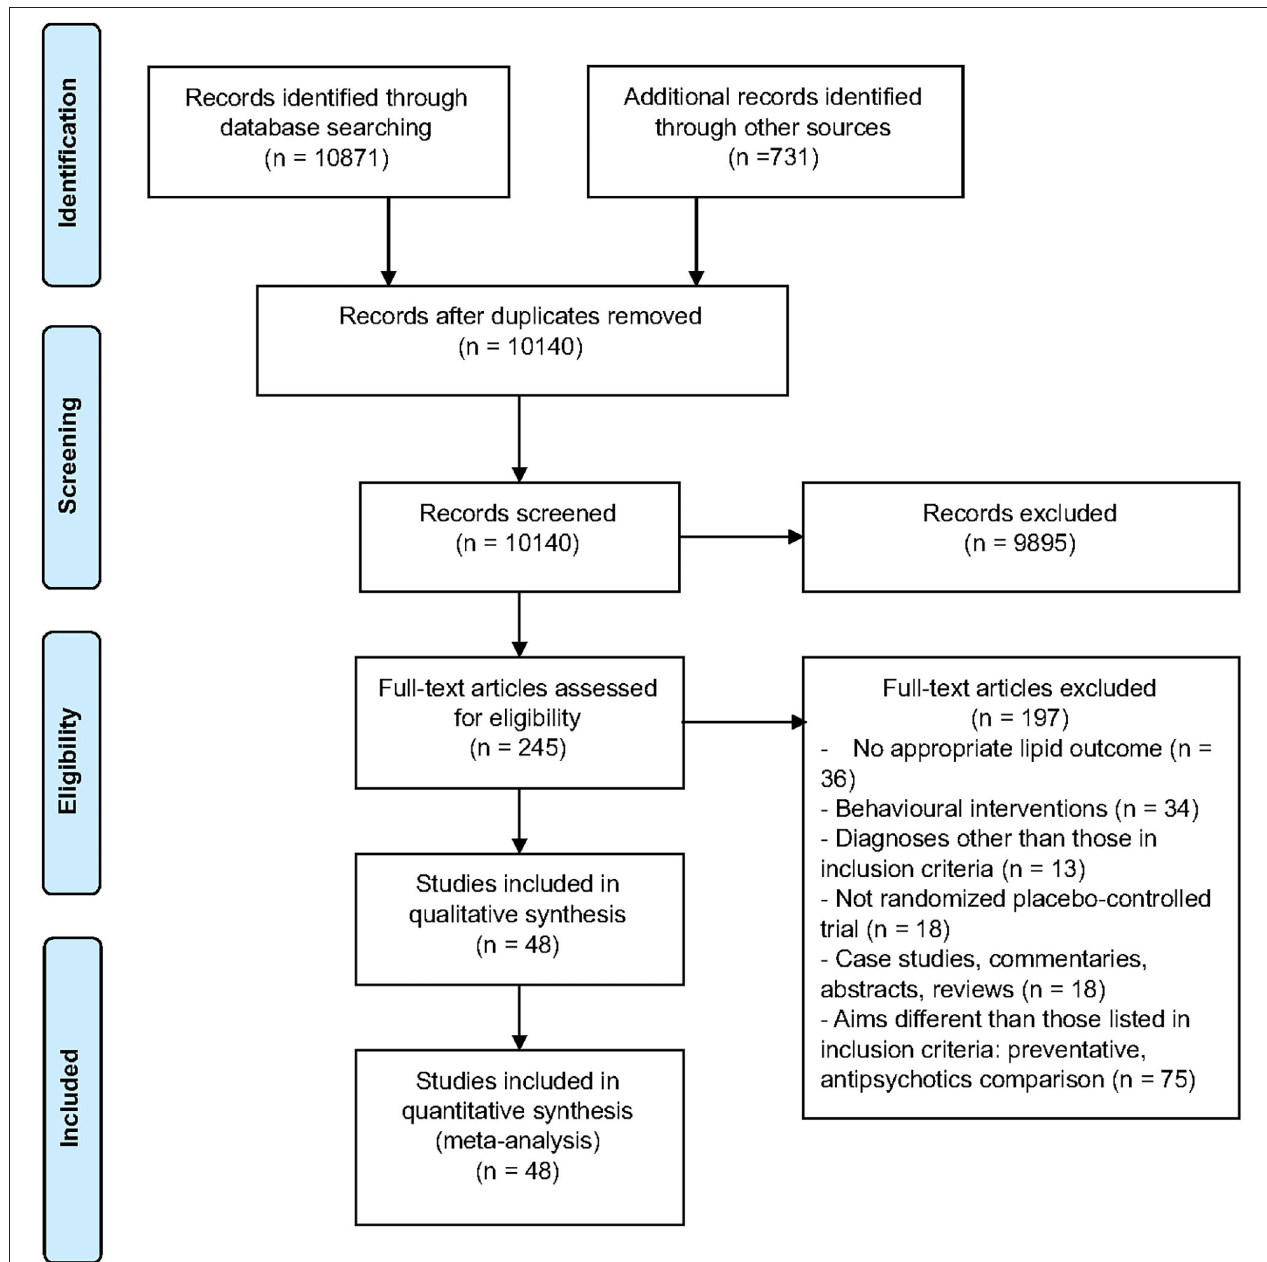
FIGURE 1 | PRISMA flow chart describing the selection process of included articles for the systematic review and meta-analysis.